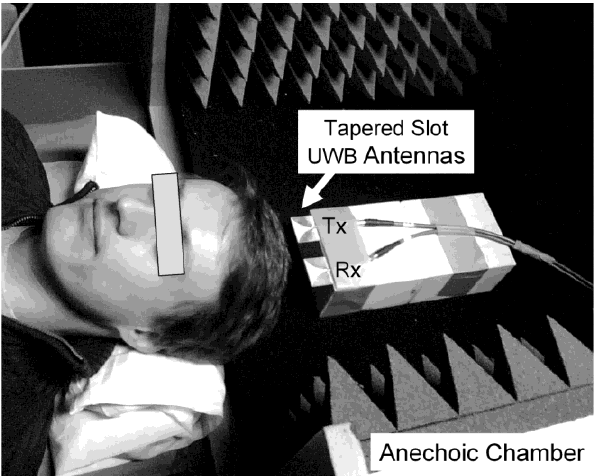
Figure 3. Spontaneously breathing volunteer in supine position, exposed to UWB signals in the GHz range using transmitting (Tx) and receiving (Rx) tapered slot antennas (Vivaldi